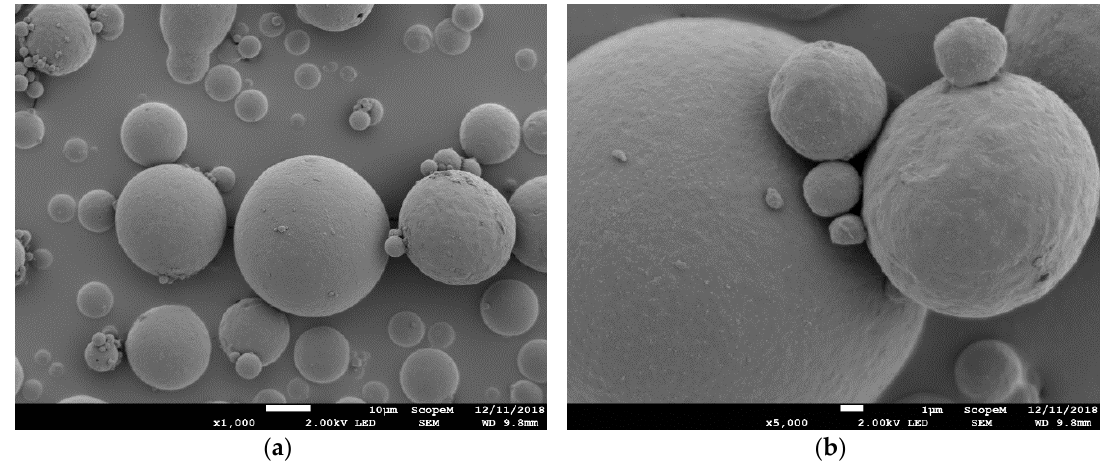
Figure 7. ( a ) Overview of spherical PBT particles; ( b ) Detail of PBT particles.